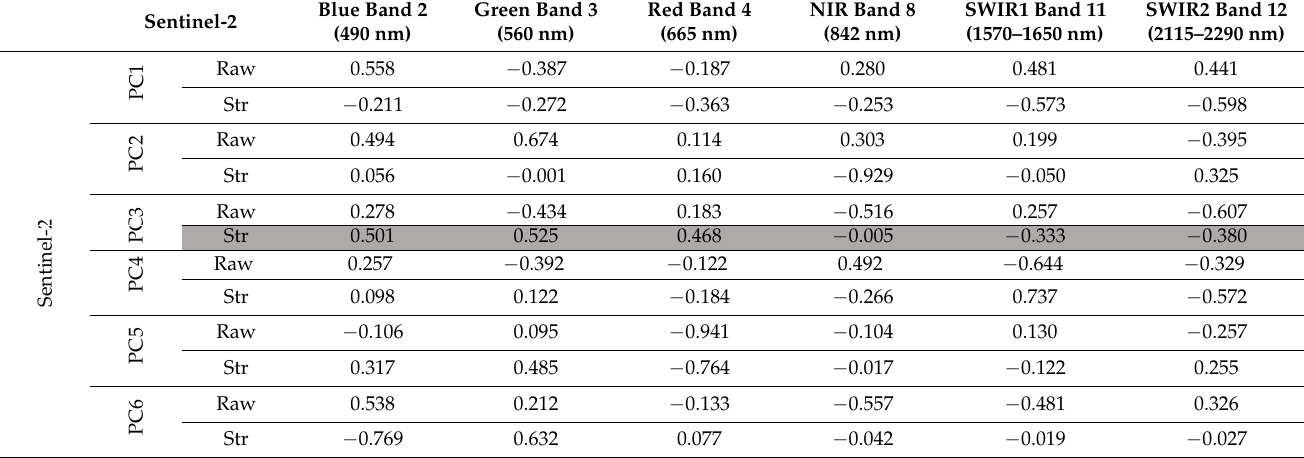
Table 4. Eigenvector loadings after applying FPCS to raw (Raw) and stretched (Str) Sentinel-2 MSI data. The highlighted components were used in generating the final image shown in Figure